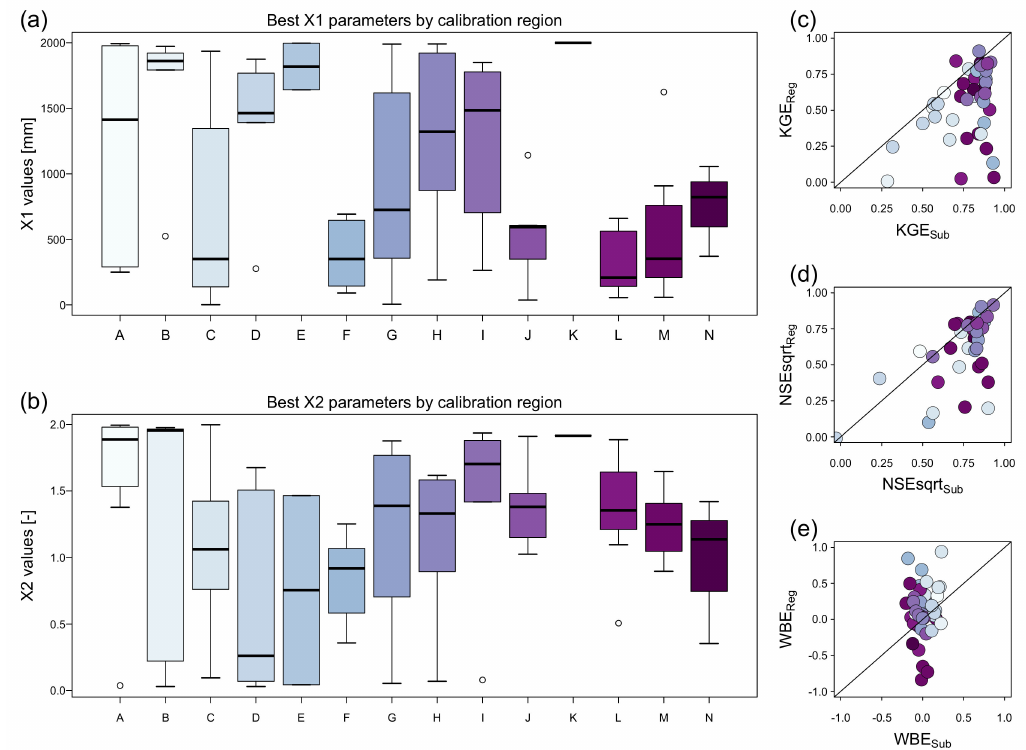
Figure 8. Boxplot of calibrated ( a ) X1 and ( b ) X2 parameters for each calibration region. ( c – e ) Scatterplot of statistical metrics used for evaluating model performance changes using calibrated GR2M model parameters by sub-regions (Sub) and applying the median of X1 and X2 for each calibration region